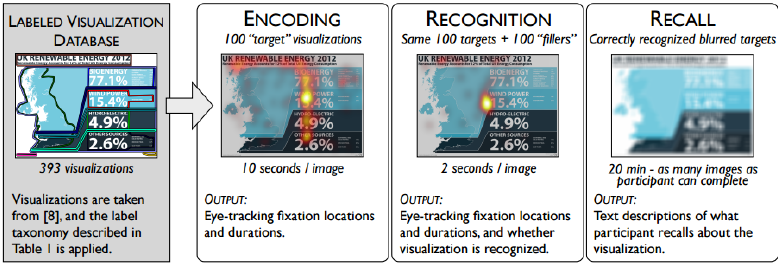
Figure 31. Borkin et al. design three-phase experiment to evaluate viewer performance of recognition and recall [30]. Image courtesy of Borkin et al.